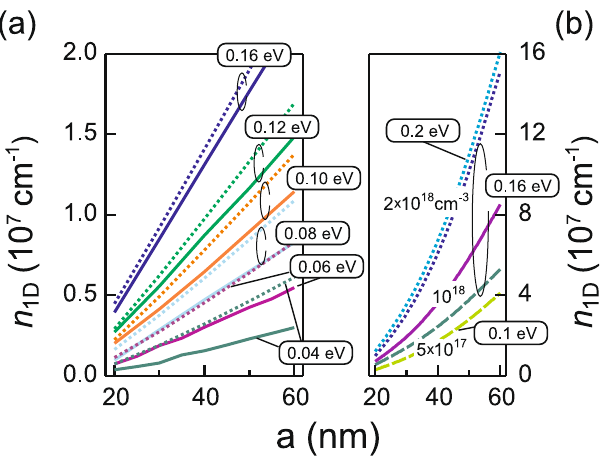
Figure 6. ( a ) One-dimensional electron density as a function of the nanowire side length plotted for various position of the Fermi level with respect to the conduction band edge at the surface for the lattice temperature T = 4 K (solid line) and 300 K (dotted line). ( b ) One-dimensional electron density as a function of the nanowire side length plotted for various position of the Fermi level with respect to the conduction band edge at the surface for the lattice temperature T = 4 K and n-type doping density set to 5 × 10 17 cm − 3 (dashed line), 10 18 cm − 3 (solid line), and 2 × 10 18 cm − 3 (dotted